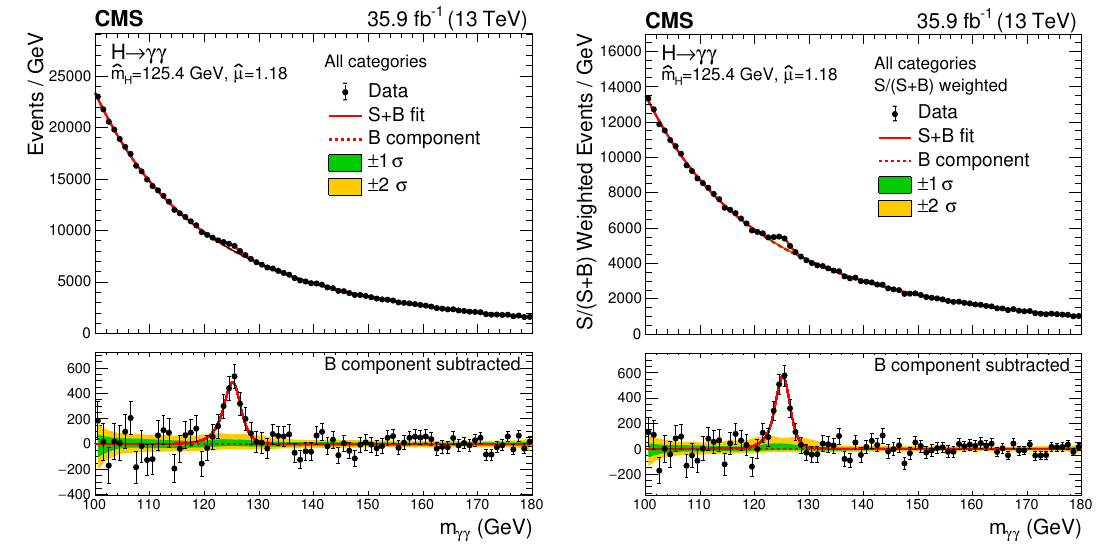
Figure 14 . Data and signal-plus-background model (cid:12)ts for all categories summed (left) and where the categories are summed weighted by their sensitivity (right). The one (green) and two (yellow) standard deviation bands include the uncertainties in the background component of the (cid:12)t. The lower panel in each plot show the residuals after the background subtraction.